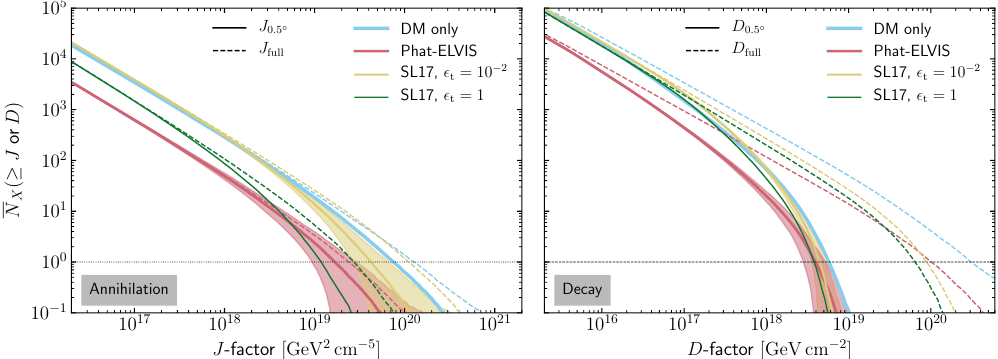
Figure 3. Cumulative source count distribution of galactic subhalos (full sky, averaged over 1000 simulations) for all configurations gathered in Table 1. ( Right panel ): decaying DM. In both panels, the solid lines show the distribution of the J -factors within α int = 0.5 ◦ , whereas the dashed lines for integrating over the full halo extents up to r 200 or r t